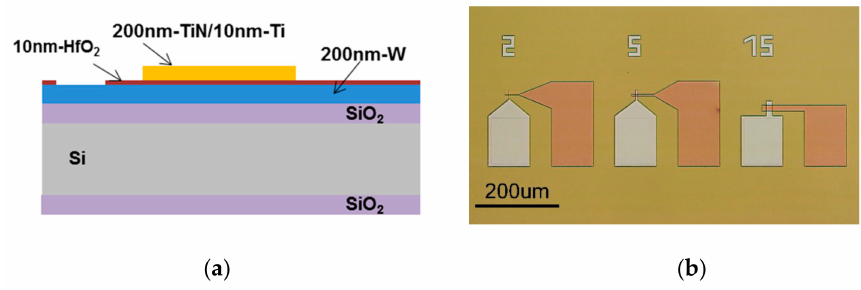
Figure 1. ( a ) Schematic device cross-section; and ( b ) Top view optical microscope image.